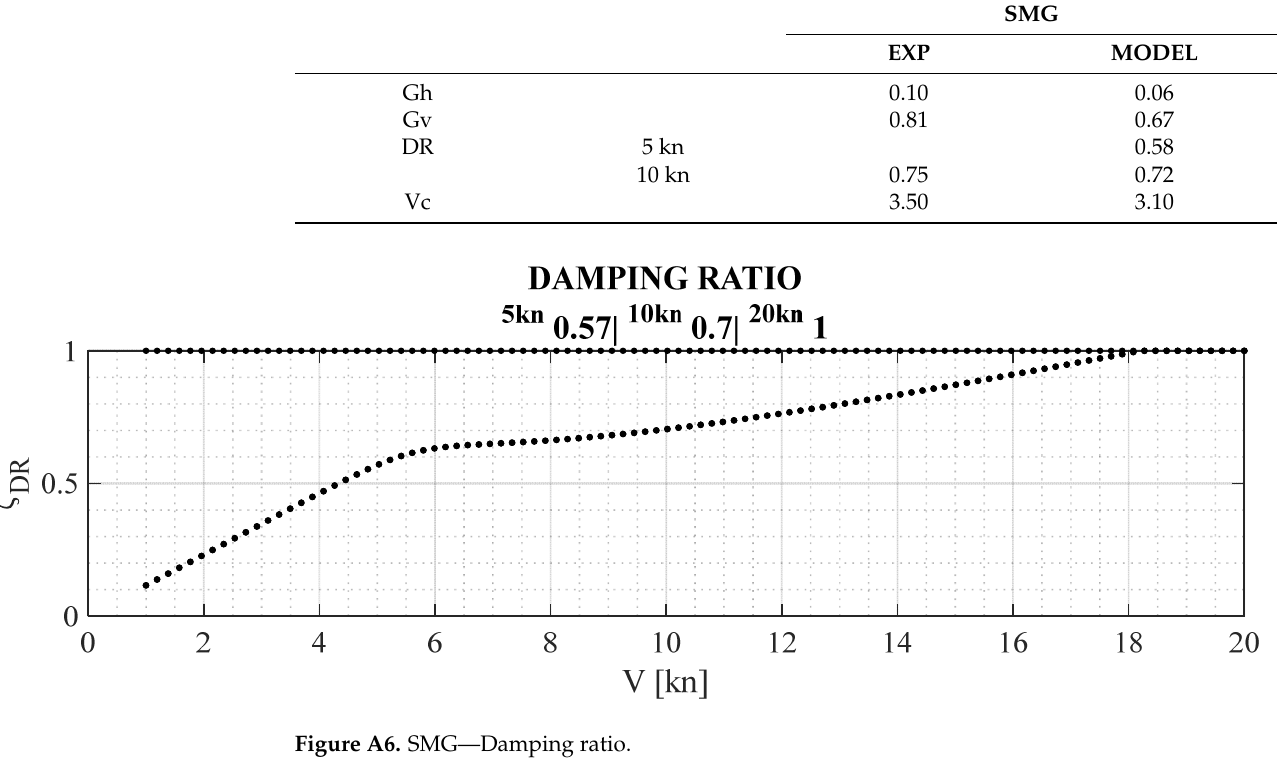
Figure A6. SMG—Damping ratio.